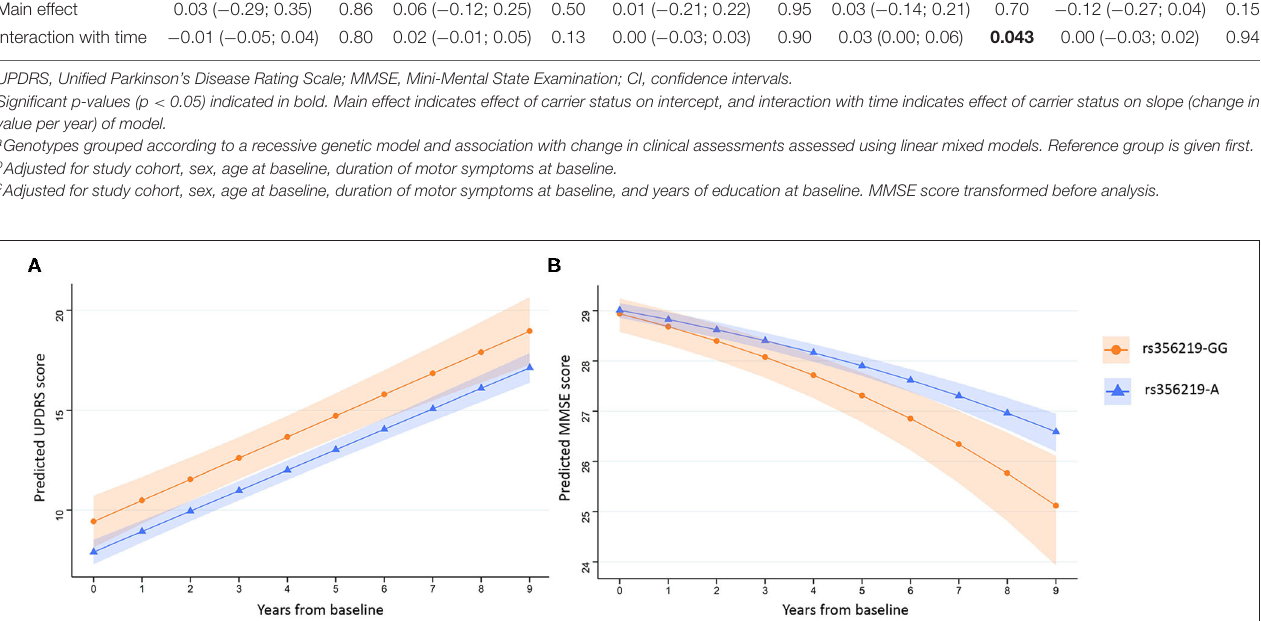
FIGURE 1 | Prediction of UPDRS II and MMSE scores over time. Average predicted UPDRS II (A) and MMSE (B) scores with confidence bands for first 9 years after diagnosis of PD for rs356219-GG allele carriers (orange, circles) and rs356219-A allele carriers (blue, triangles). UPDRS, Unified Parkinson’s Disease Rating Scale; MMSE, Mini-Mental State